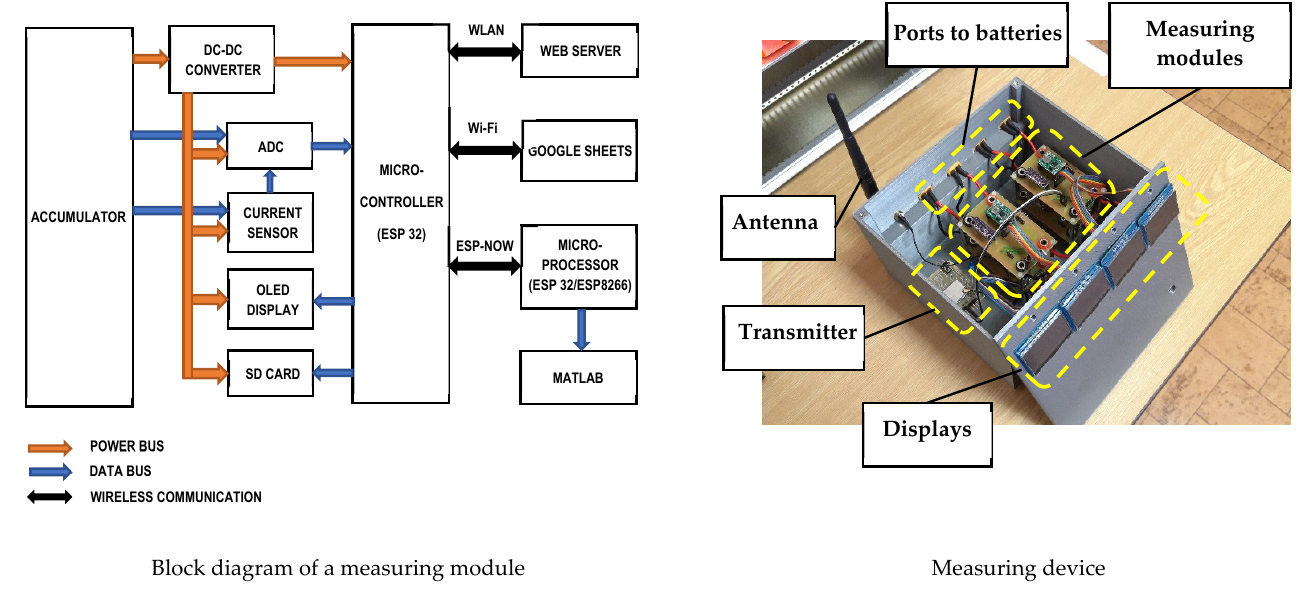
Figure 23. The measuring device [58].